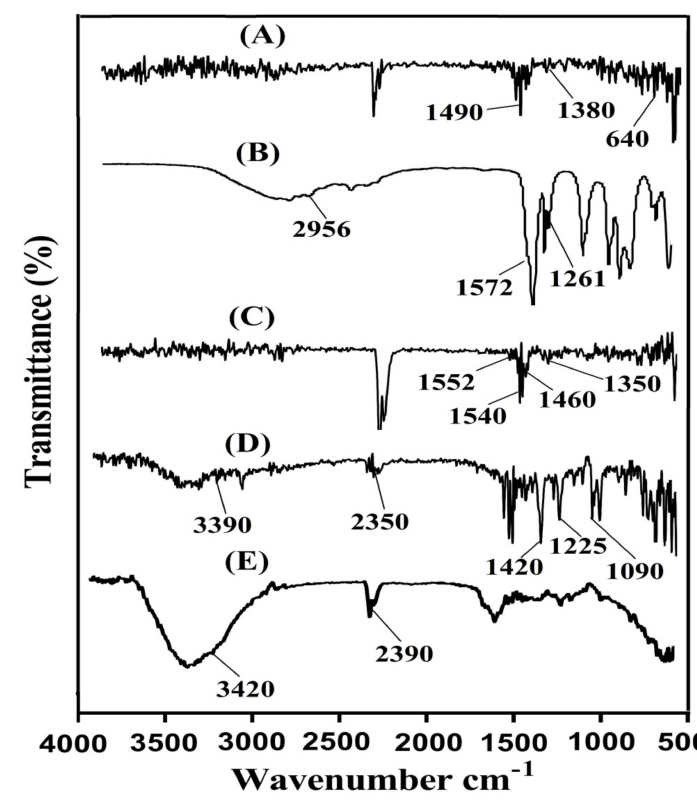
Figure 6. Fourier transform infrared spectroscopy (FTIR) of ( A ) SPS, ( B ) AA, ( C ) unloaded SPSPAA hydrogels, ( D ) KT, ( E ) loaded SPSPAA hydrogels.